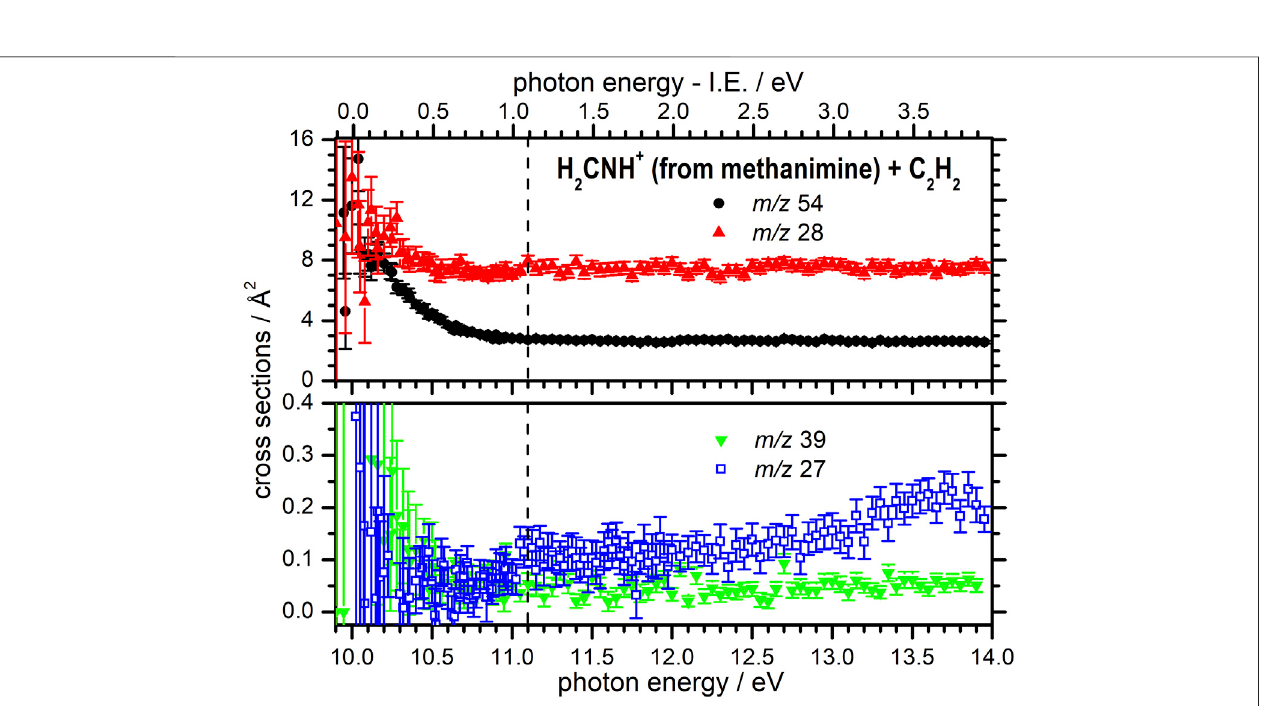
FIGURE3| Reactivecrosssectionsasafunctionof E phot forthereactionofH 2 CNH + (cid:129) withC 2 H 2 .Thecollisionenergyis fi xedat E CM ∼ 0.1 eV.The x axisscaleatthe top is the difference between E phot (bottom x scale) and the AE for production of the parent ion from photoionization of methanimine, and equal to 10.01 ± 0.08 eV, as detailed in the text. The vertical dashed lines indicate the photon energies at which data have been collected as a function of E CM (see Figure 5 ).